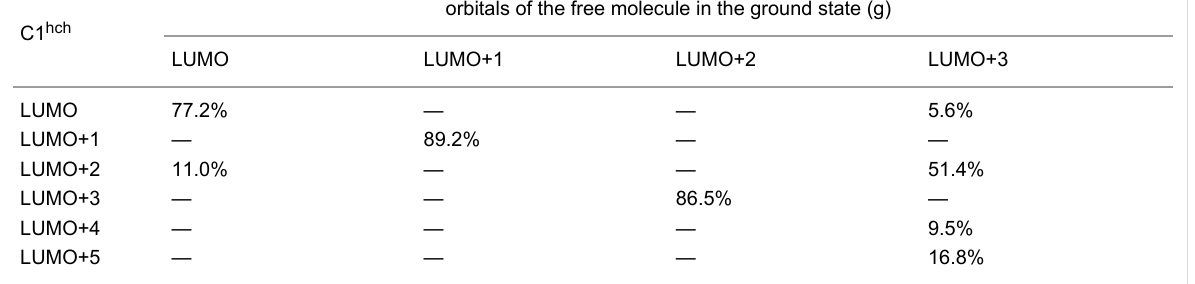
Table 2: Overlap of the molecular orbitals of the gas phase pentacene with a half core hole (hch) at C1 in the V-shaped geometry, with those of the free molecule in the ground state, g. Values below 0.5% are not reported here.